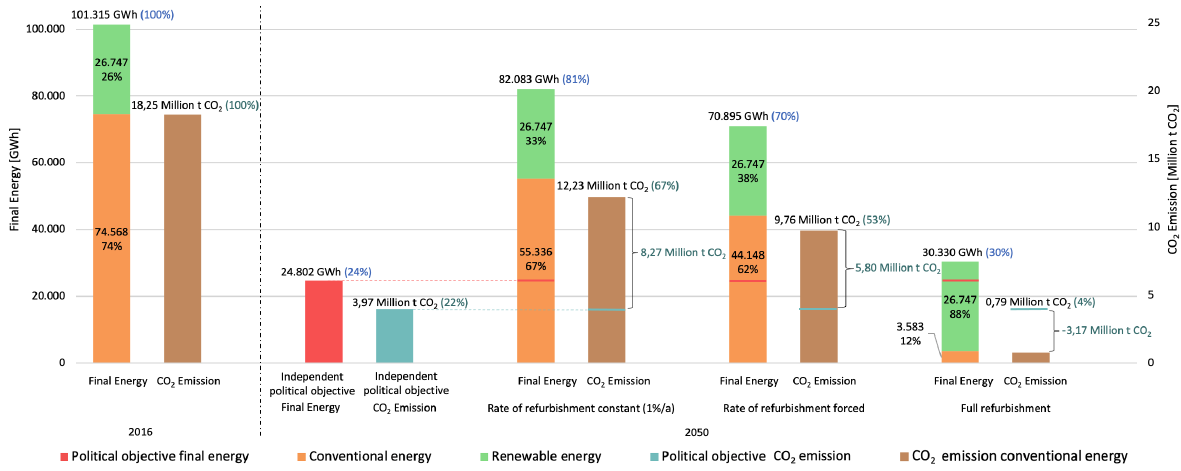
Figure 5. Demand and objective values for final energy and for CO